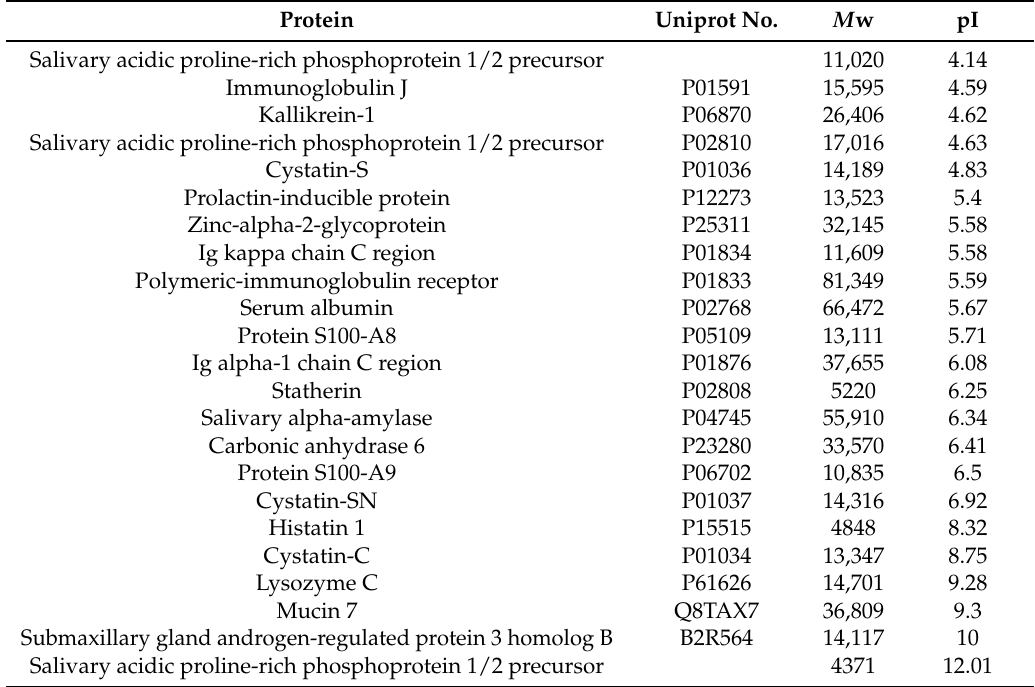
Figure 3. Mass and pI distribution of salivary proteins and peptides of human acquired enamel pellicle that bind to CPP ( α S1 -CN (59–79), β -CN (1–25)). Table 1. A list of known proteins of human acquired enamel pellicle shown to bind CPP.